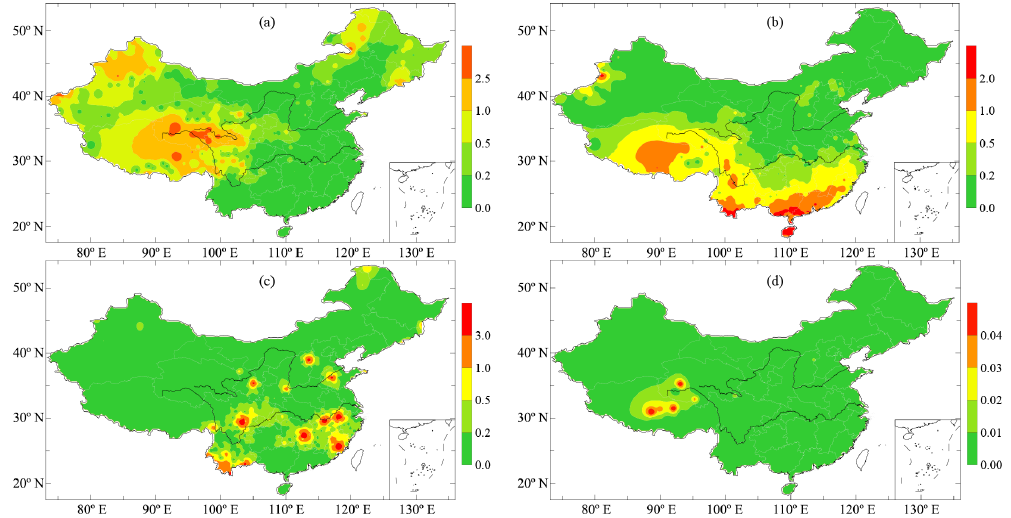
Figure 9. Spatial distribution of annual number of high-impact weather spells with more than 7 consecutive days in China during 1959–2014 (unit: timesyr − 1 ; (a) snowfall spells, (b) thunderstorm spells, (c) foggy weather spells, (d) hailstorm spells).